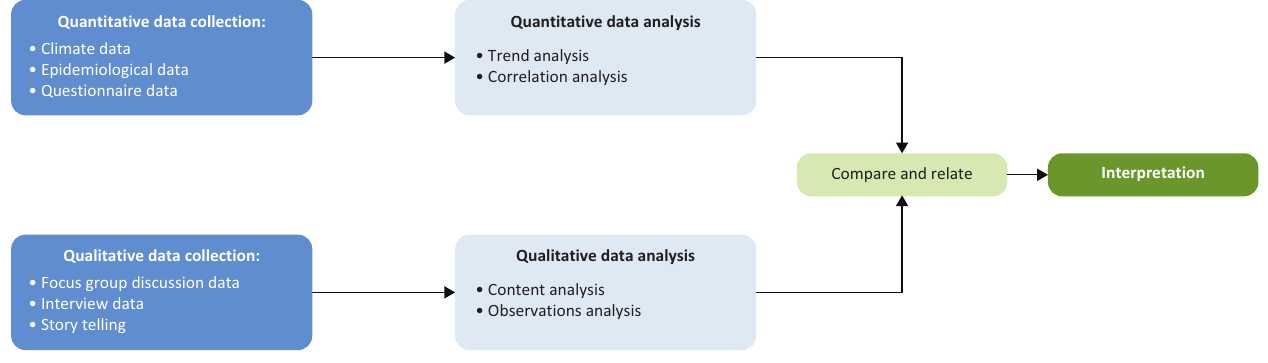
FIGURE 2: Mixed-methods